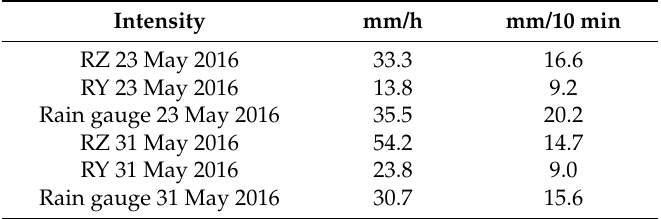
Table 4. Comparison of the radar-based precipitation with rain gauge data.